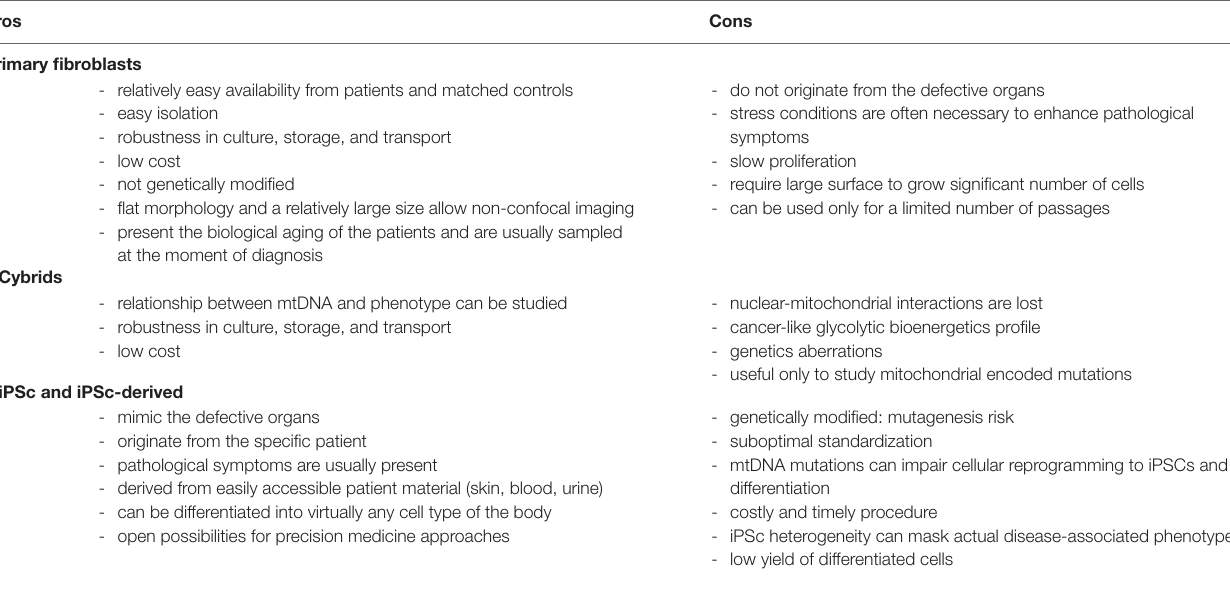
TABLE 2 | Human cell models used in mitochondrial